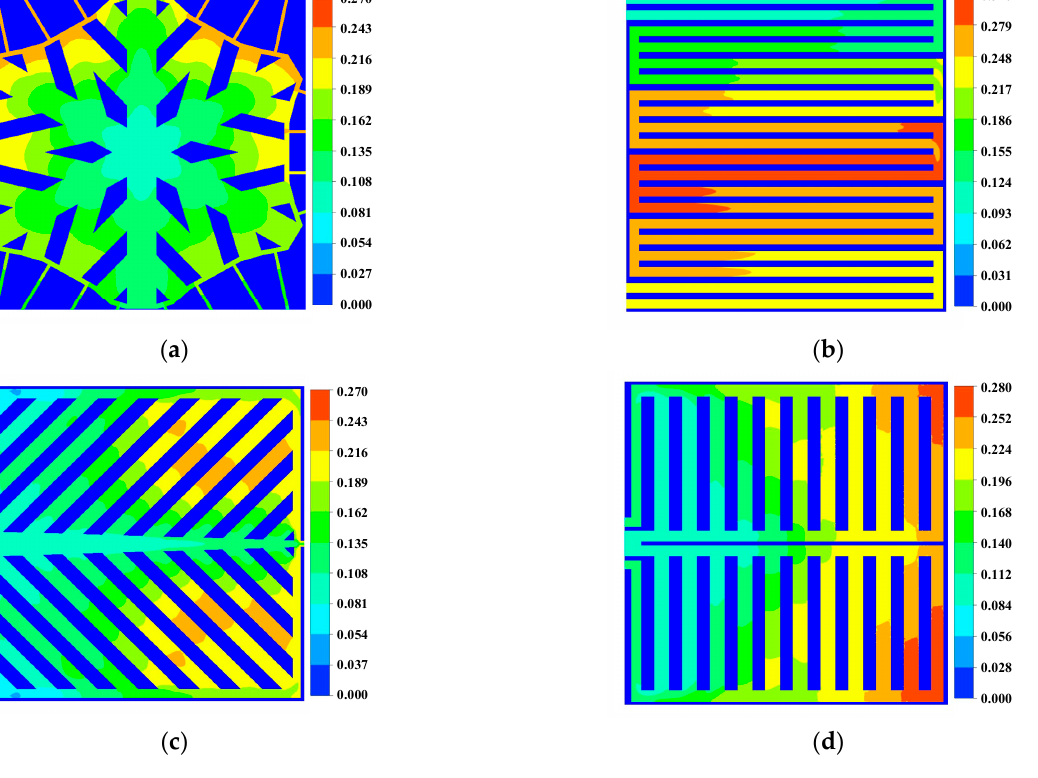
Figure 7. Water mass fraction in cathode channel (0.8 V): ( a ) Snowflake bionic flow channel; ( b ) dual serpentine flow channel; ( c ) leaf-shape bionic flow channel; ( d ) lung-shape bionic flow channel.